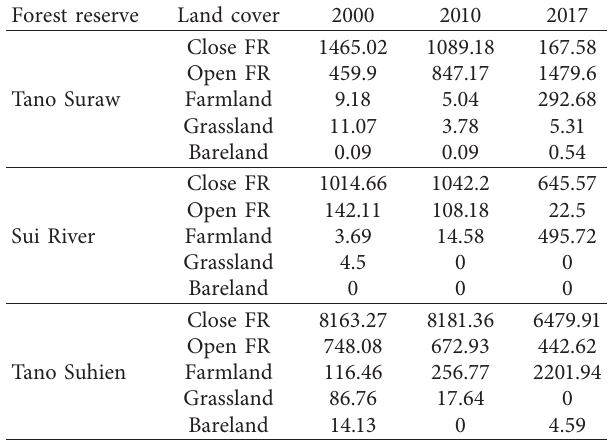
Table 14: FR risk indication.